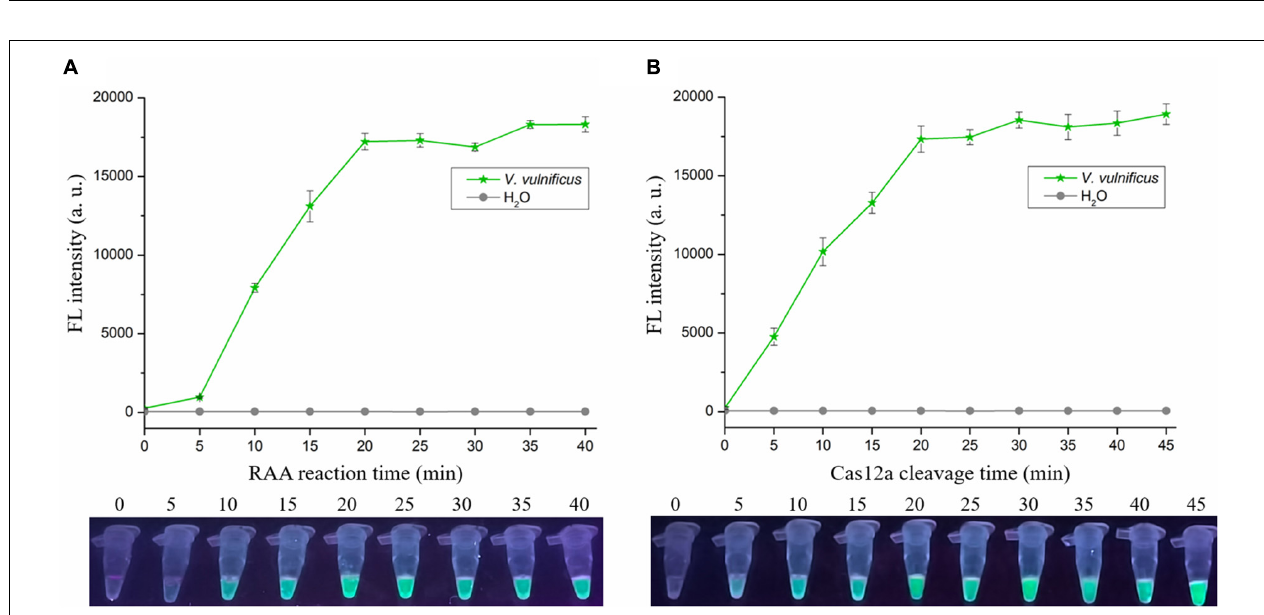
FIGURE 2 | Screening optimal RAA primers and crRNA for the RAA-CRISPR/Cas12a assay. (A) Gel electrophoresis analysis of RAA products amplified with different primer set. M, 500 DNA marker; lanes 1–9, RAA products amplified by primer set 1, 2, 3, 4, 5, 6, 7, 8, and 9, respectively. (B) crRNA sequences designed in this study. (C) Analysis of fluorescence signals triggered by the different crRNA using a multifunctional microplate reader (upper) or a UV torch (below). Data is one representative of three experiments.